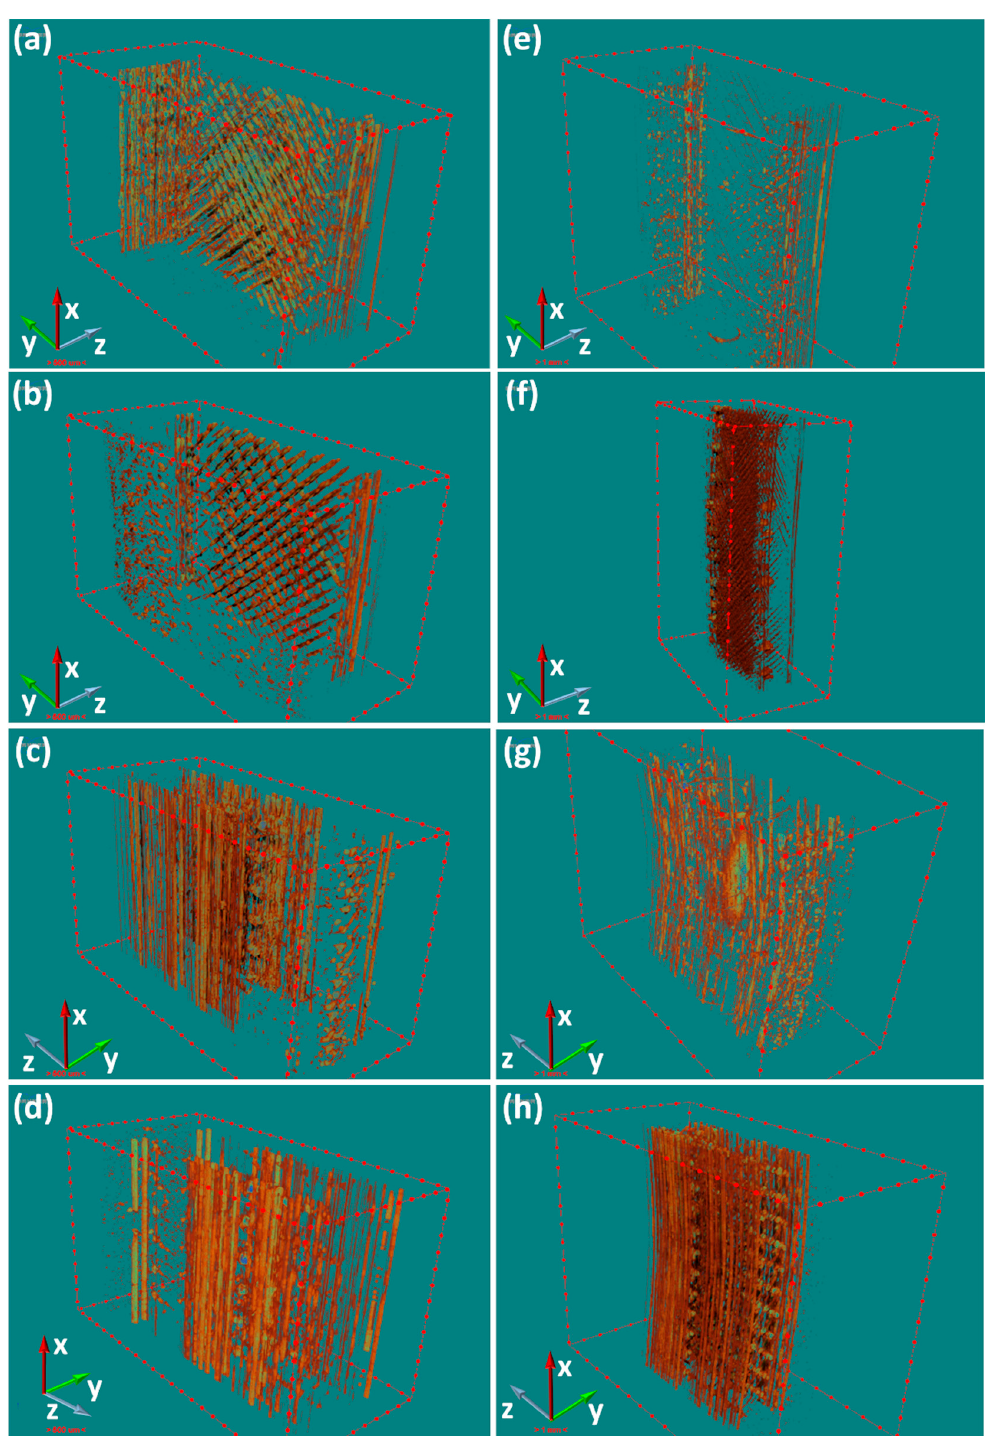
Figure 4. X-CT scanning of printed PEEK and CF / PEEK composites. Left ( a – d ): before bending; right ( e – h ): after bending. ( a ) ( b ) illustrate the horizontally printed parts and ( c ) ( d ) are the vertically printed parts. The Z-axis is building orientation, and the dark brown parts are pores. As for the horizontal and vertical parts, the external force is along the opposite direction of the Z-axis and the direction of the Y-axis, respectively.